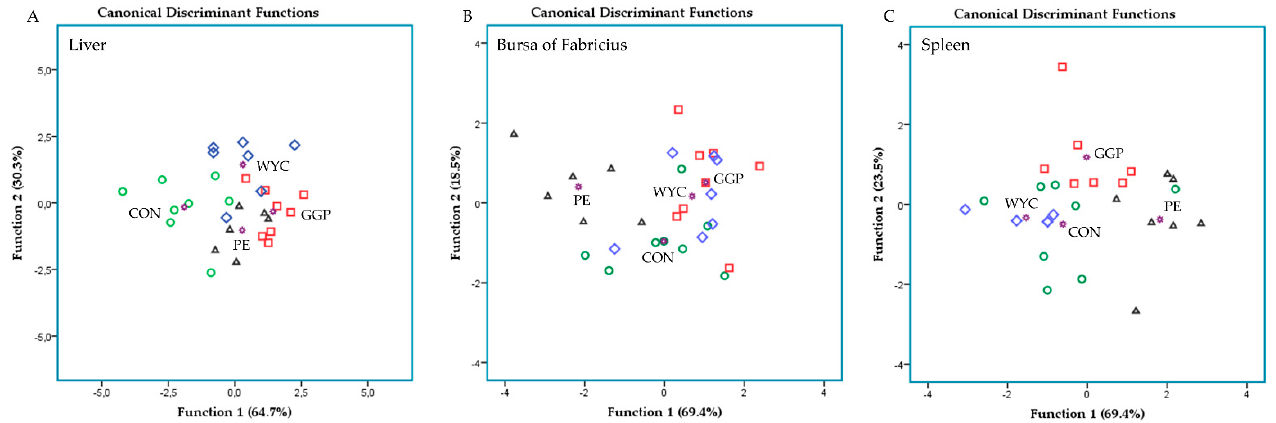
Figure 4. Plots depicting the discrimination of the four dietary groups (CON green, GGP red, WYC blue, and PE black) based on the pooled data of the ( A ) liver, ( B ) bursa of Fabricius, and ( C ) spleen relative transcript levels of immune-related genes.